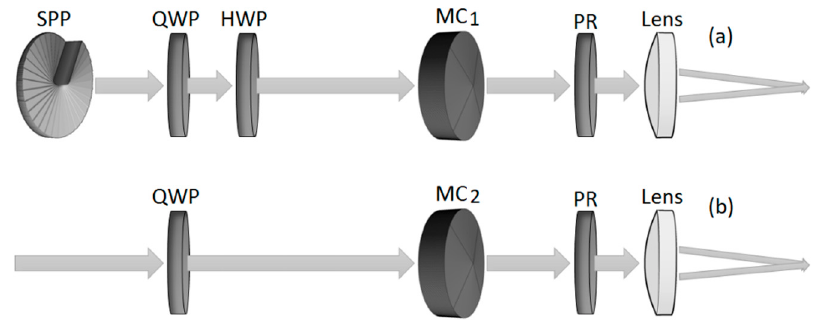
Figure 2. Schematic representation of the optical system corresponding to variation 1 ( a ); schematic representation of the optical system corresponding to variation 2 ( b ).